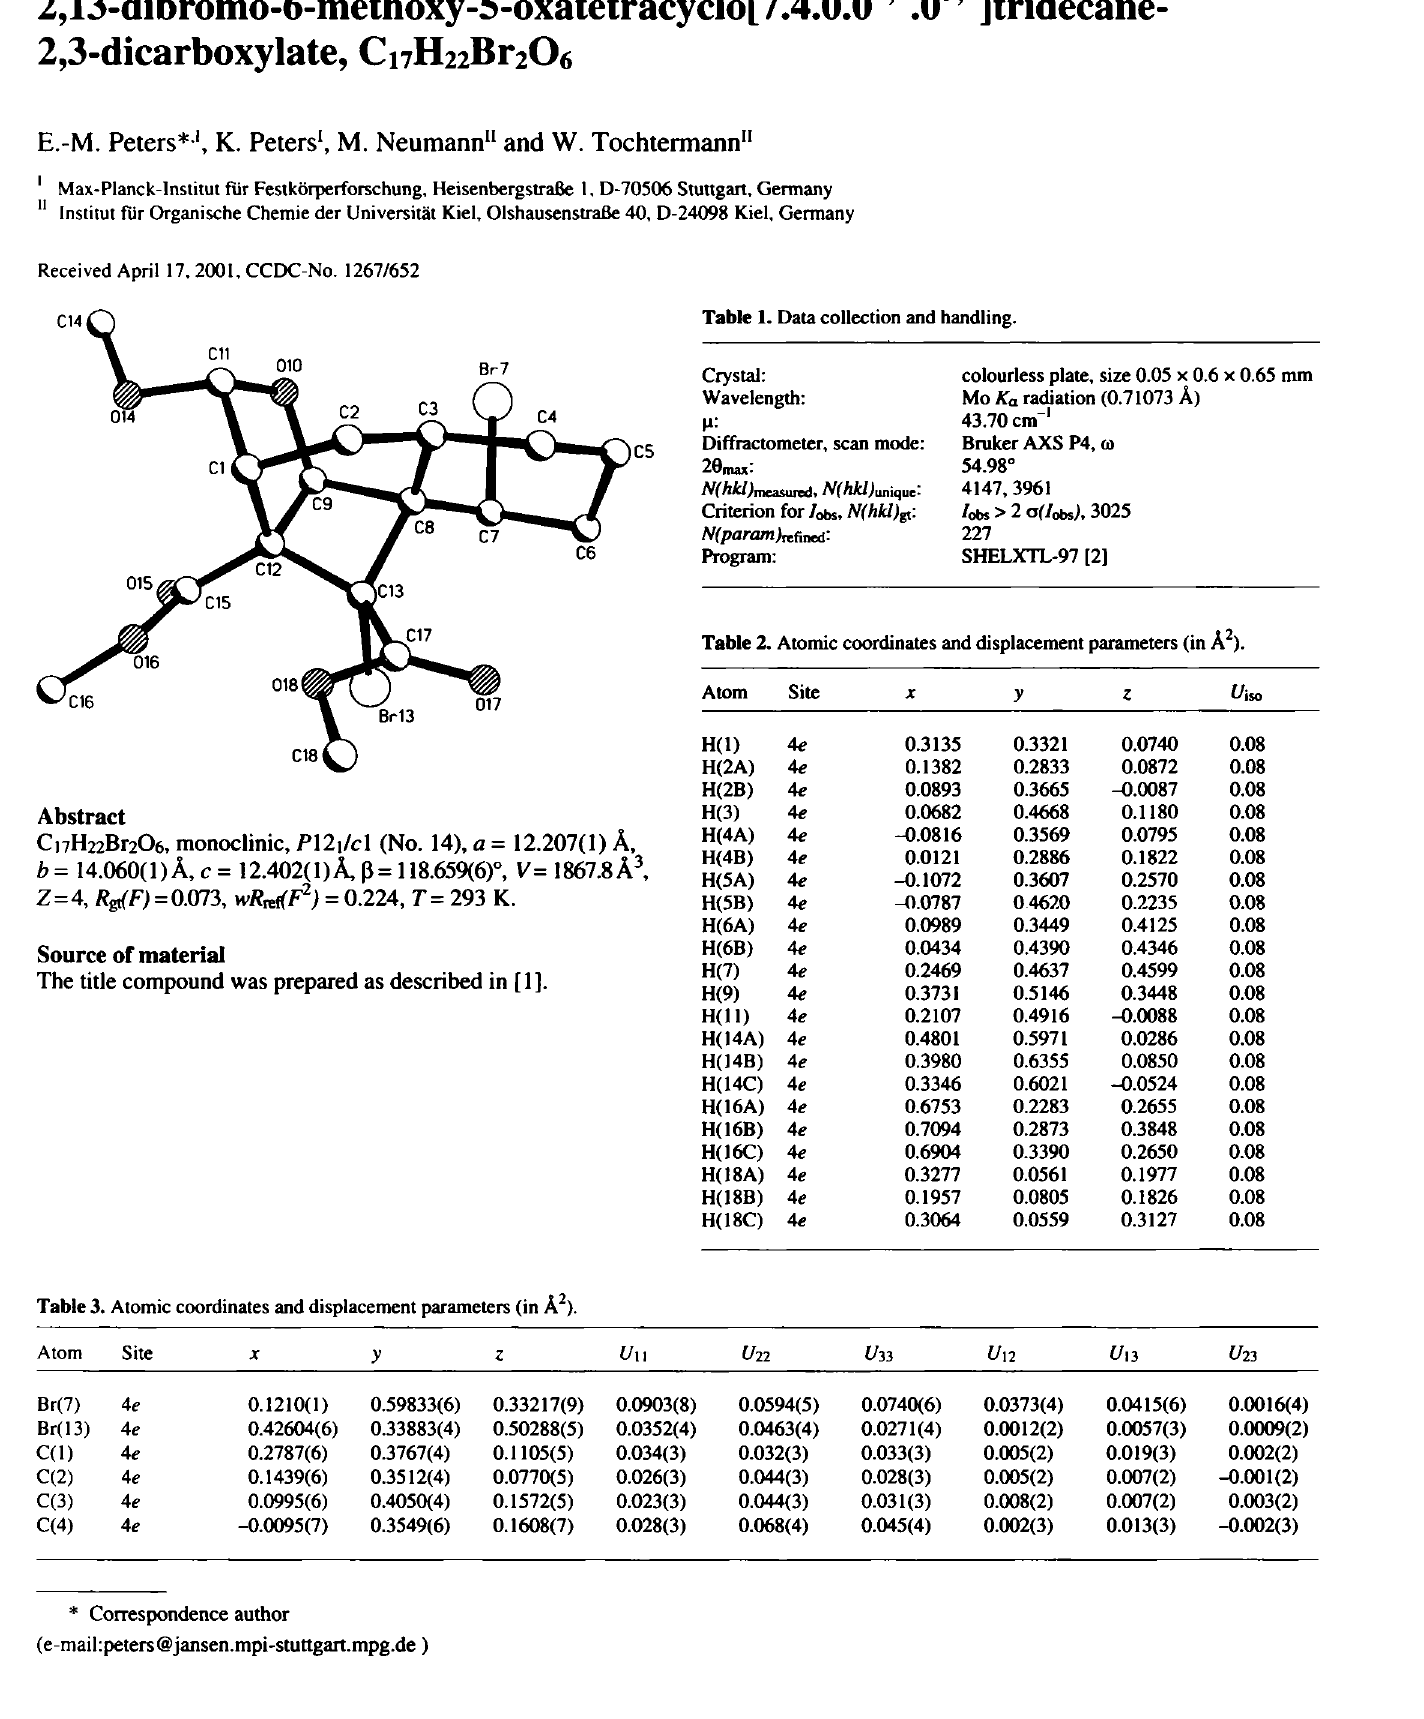
Table 1. Data collection and handling.